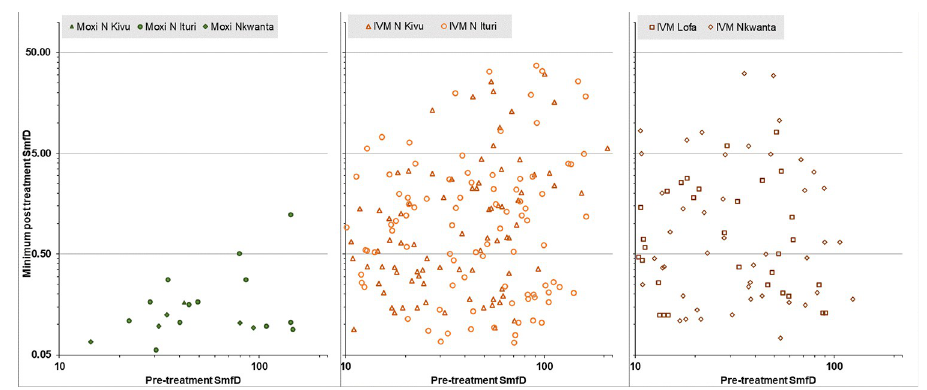
Fig 8. Minimum SmfD for participants with detectable SmfD at all post-treatment evaluations. Left: moxidectin treated participants, center: ivermectin treated participants from DRC, right: ivermectin treated participants from Lofa country and Nkwanta North, IVM ivermectin, Moxi moxidectin, SmfD Skin microfilariae density.